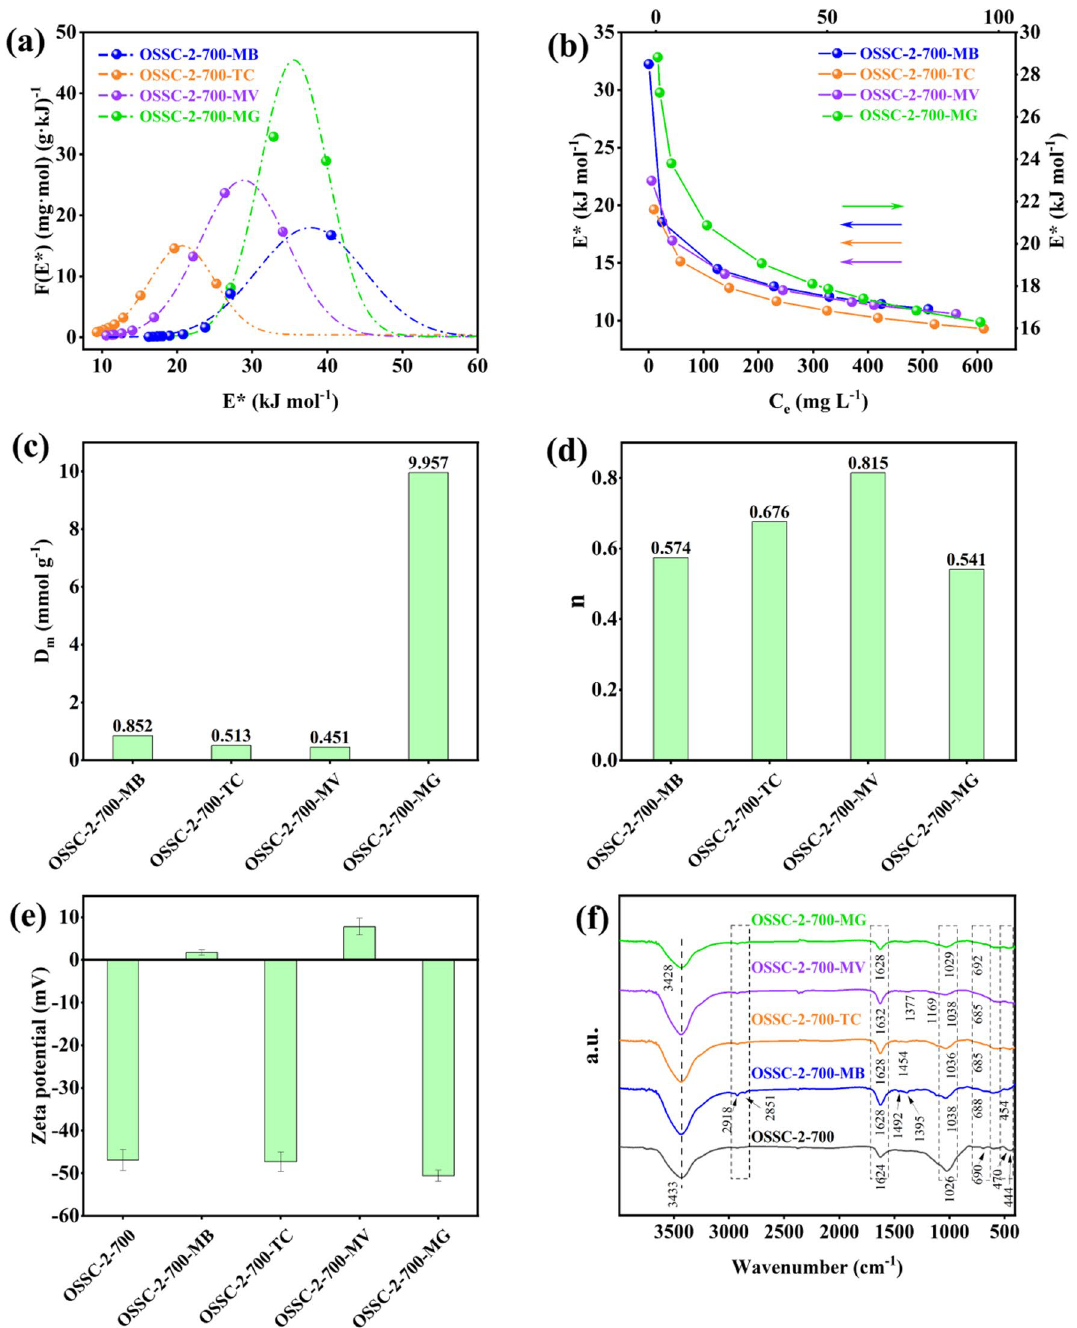
Fig. 7 The analysis of SED model ( a , b ) and statistical physical model ( c , d ). Zeta potentials ( e ) and FT-IR spectra ( f ) of OSSC-2-700 before and after adsorption of organic